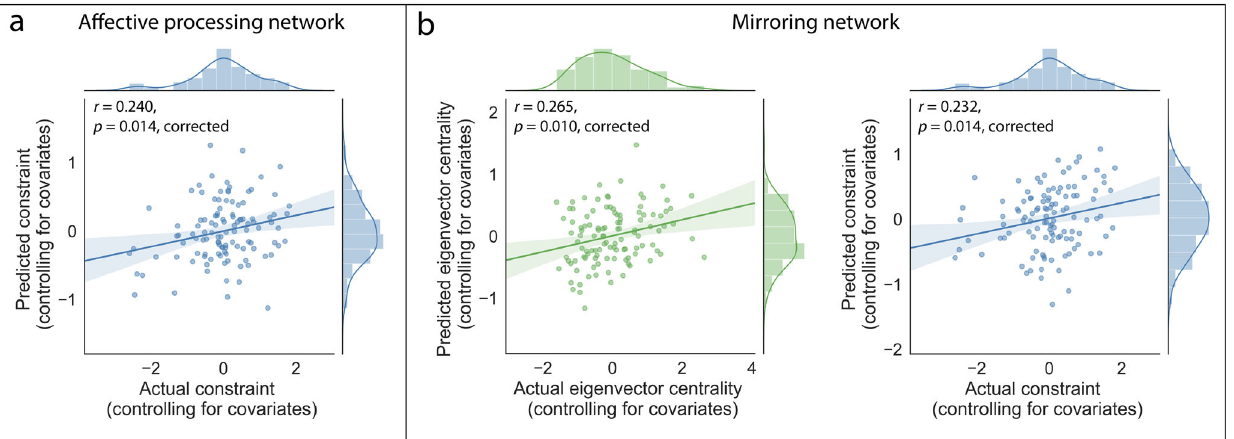
Fig. 4 Multivariate patterns of white matter microstructural integrity predicted real-world social network position characteristics. a Whereas patterns of white matter microstructural integrity in the affective processing network were predictive of constraint, b patterns of white matter microstructural integrity in the mirroring network were predictive of constraint and eigenvector centrality. For each model, the predictive performance was measured using the Pearson correlation between the actual and predicted values of the social network variable of interest ( N = 112); p -values are FDR-corrected; shaded regions indicate 95% CIs. Social network position values were normalized within cohort and square-root transformed prior to analysis. These analyses control for extraversion, demographic characteristics (i.e., age, gender), handedness, and academic the mirroring network signi fi cantly predicted individuals ’ con- straint ( r = 0.210, p = 0.013, p FDR-corrected = 0.026), eigenvector centrality ( r = 0.244, p = 0.005, p FDR-corrected = 0.019), and out- degree centrality ( r = 0.239, p = 0.006, p FDR-corrected = 0.022).